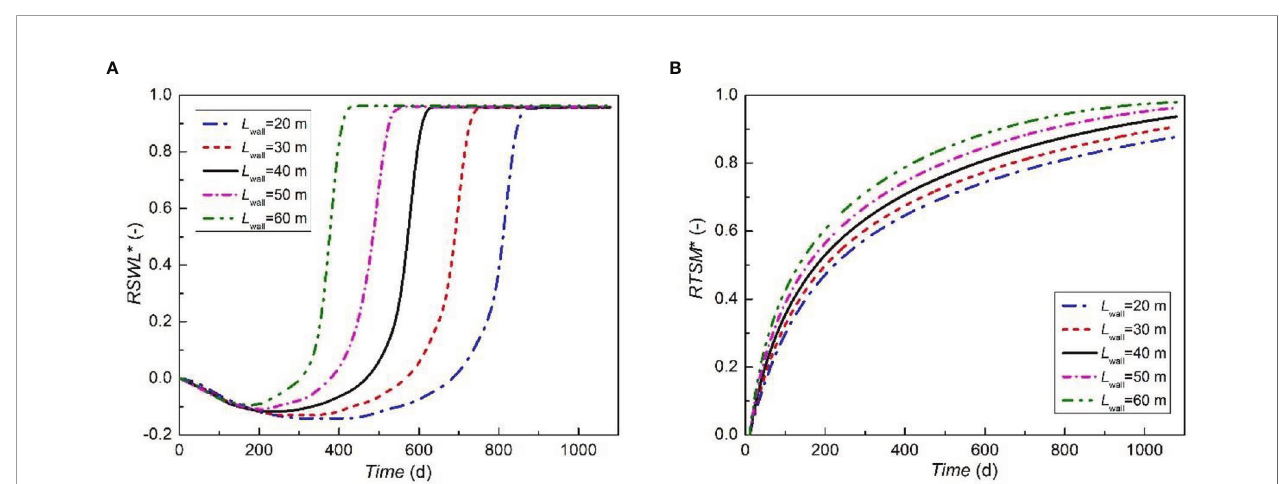
FIGURE 10 | The change of RSWL * (A) and RTSM * (B) over time after the construction of a 25 m-depth cut-off wall at 20, 30, 40, 50, and 60 m from the sea